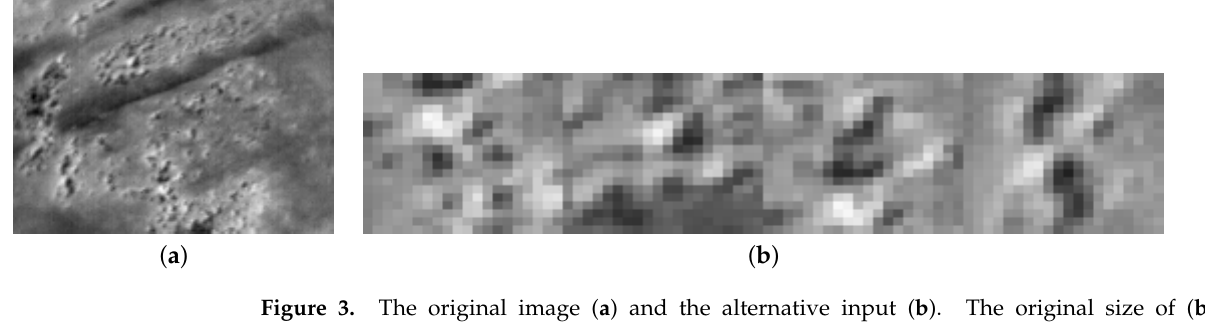
Figure 3. The original image ( a ) and the alternative input ( b ). The original size of ( b ) is 40 × 160 compared to ( a ) 160 × 120, which is one third of the number of pixels. ( a ) Sample thermal frame. ( b ) A new image constructed from extracted features from the original thermal frame with 40 × 40 as the cropping window and four features (shown at four times magnification).